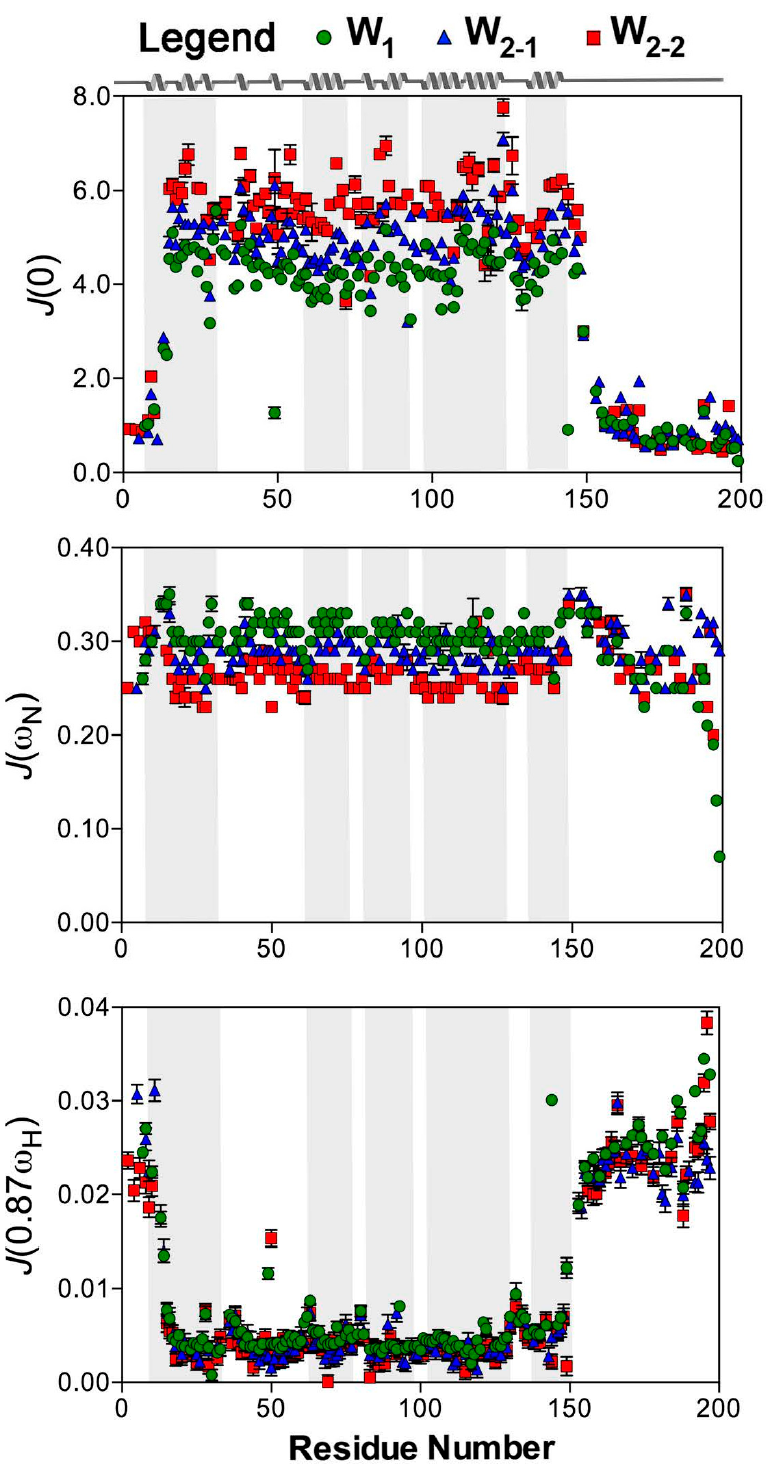
Figure 3. 15 N reduced spectral density mapping [30] at 16.4 T as a function of residue for W 1 , W 2-1 , and W 2-2 . Analysis and error propagation were carried out using Mathematica notebooks from Leo Spyracopoulos [51].